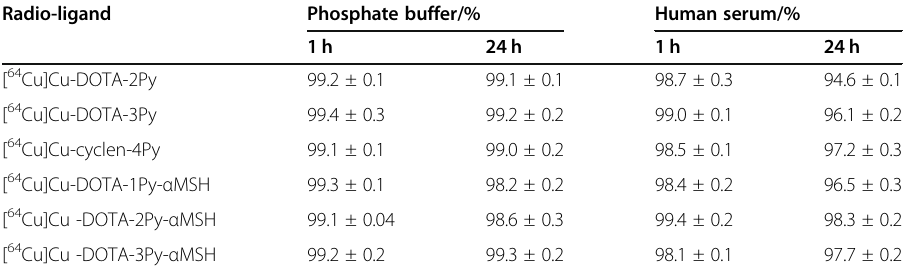
Table 1 Stability of [ 64 Cu]Cu-DOTA-xPy (x = 2 – 4) and [ 64 Cu]Cu-DOTA-xPy-MSH (x = 1 – 3) in phosphate buffer and human serum at 37 °C Radio-ligand